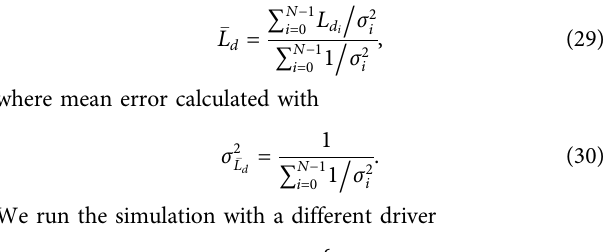
Frontiers in Astronomy and Space Sciences |